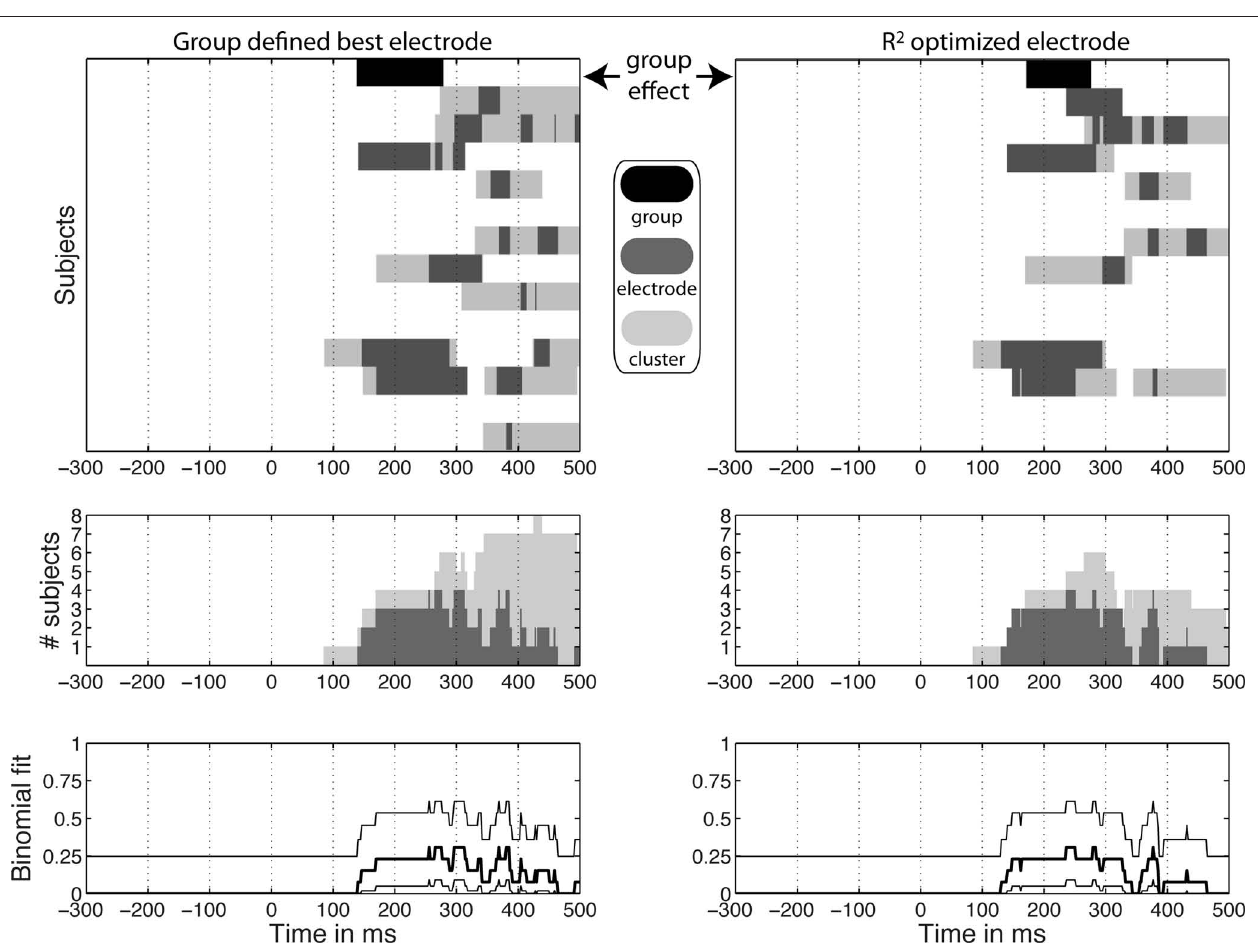
FiGuRE 9 | Significant task effects at the group level and in individual subjects. In the top graphs, significant group effects appear at the top of each column in black, above significant results in individual subjects in gray. Dark gray indicates significant effects at the group defined best electrode (left column) and at the R 2 optimized electrode (right column). Light gray indicates significant effects at the spatial–temporal cluster to which an electrode belonged. The middle graphs show the number of subjects with a significant task modulation at each time point at one electrode (light gray) or in the cluster to which it belonged (dark gray). Remember that subject 2 was the only one with stronger